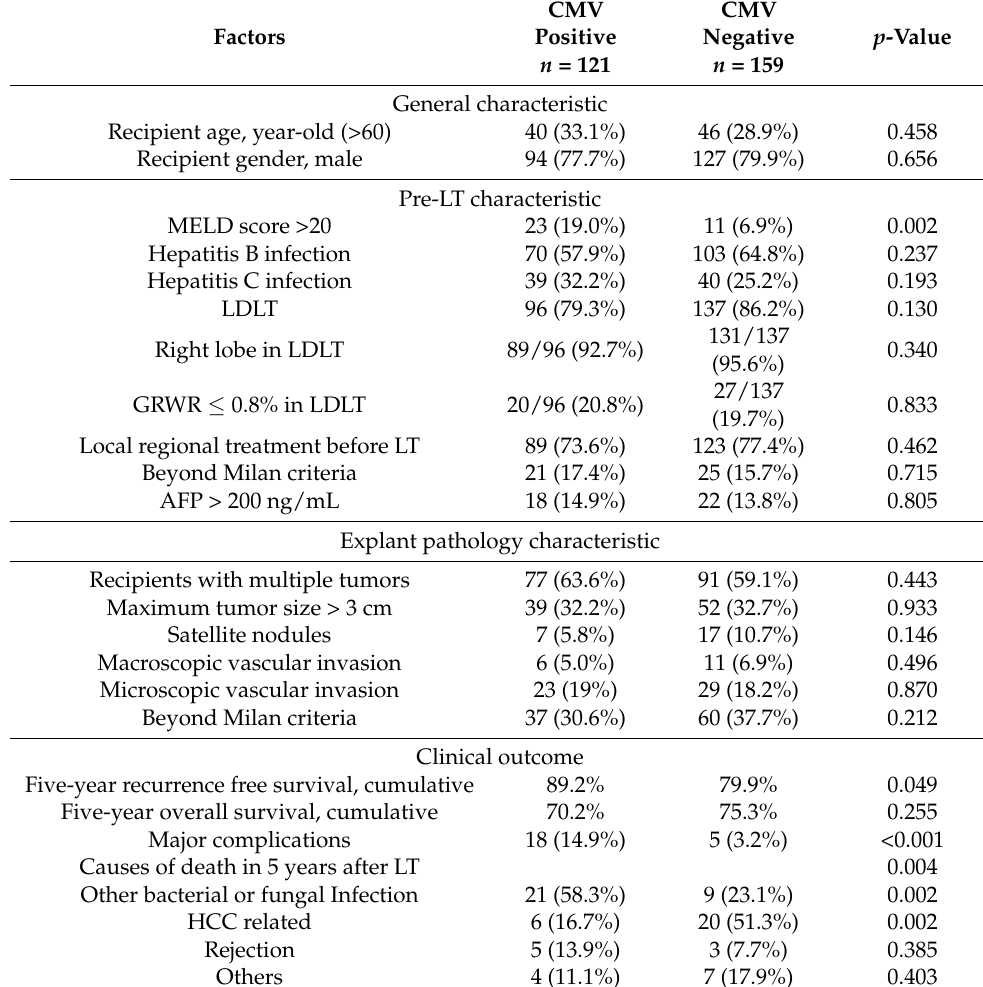
Table 2. Demographic characteristic according to PP65 antigenemia positive and negative.